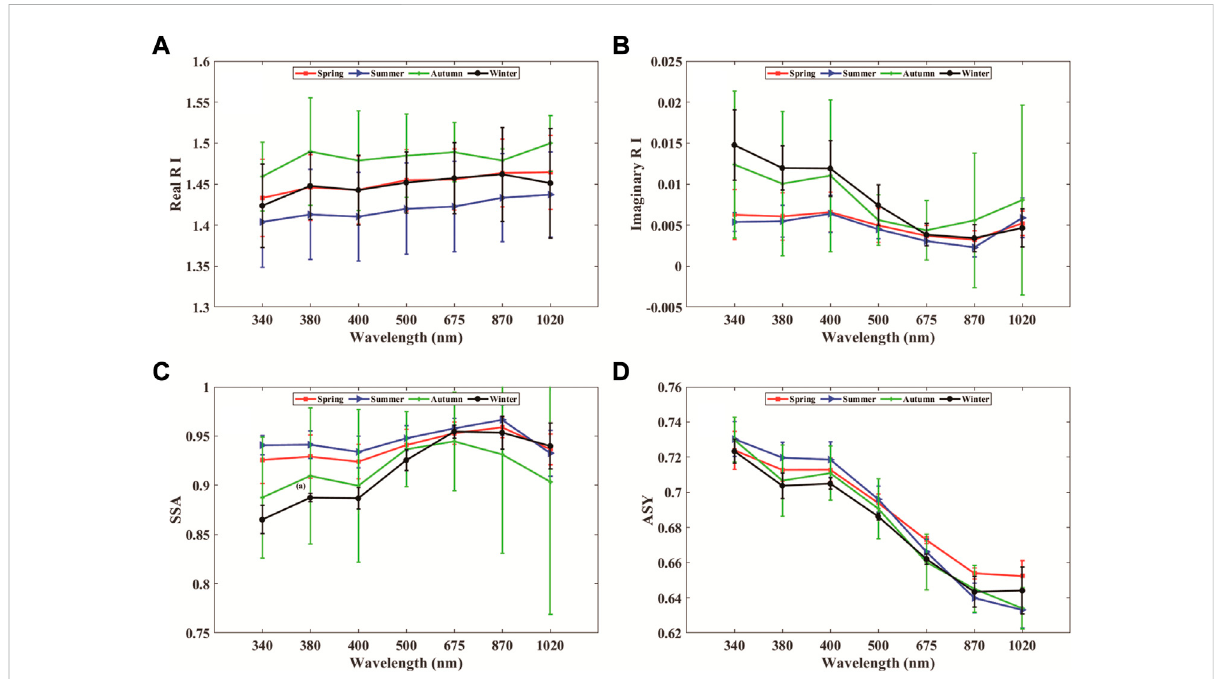
FIGURE 9 Seasonal averaged of real (A) and imaginary of RI (B) , SSA (C) , and ASY (D) at seven